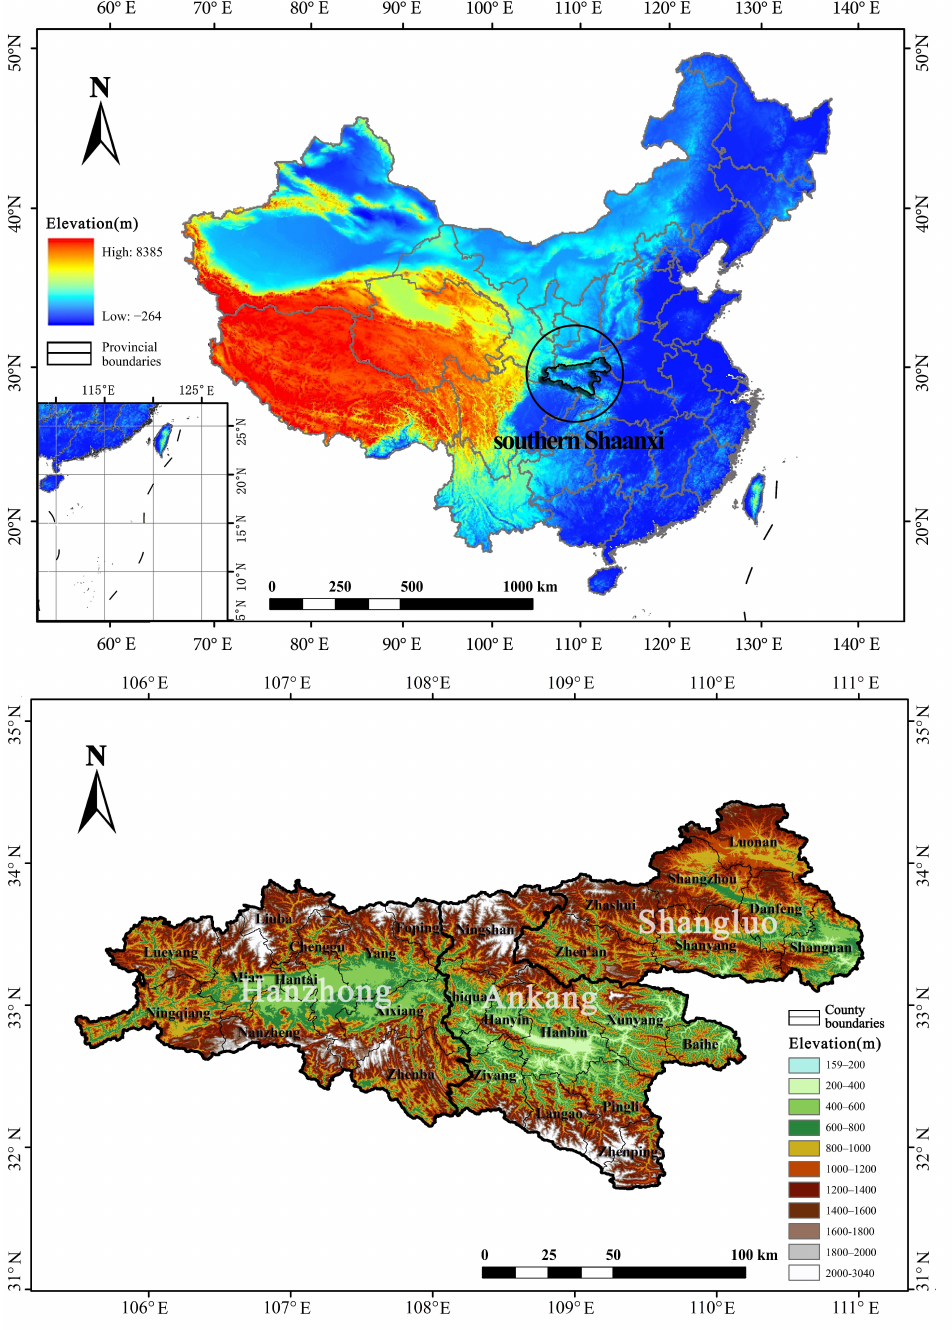
Figure 2. The location and topography of southern